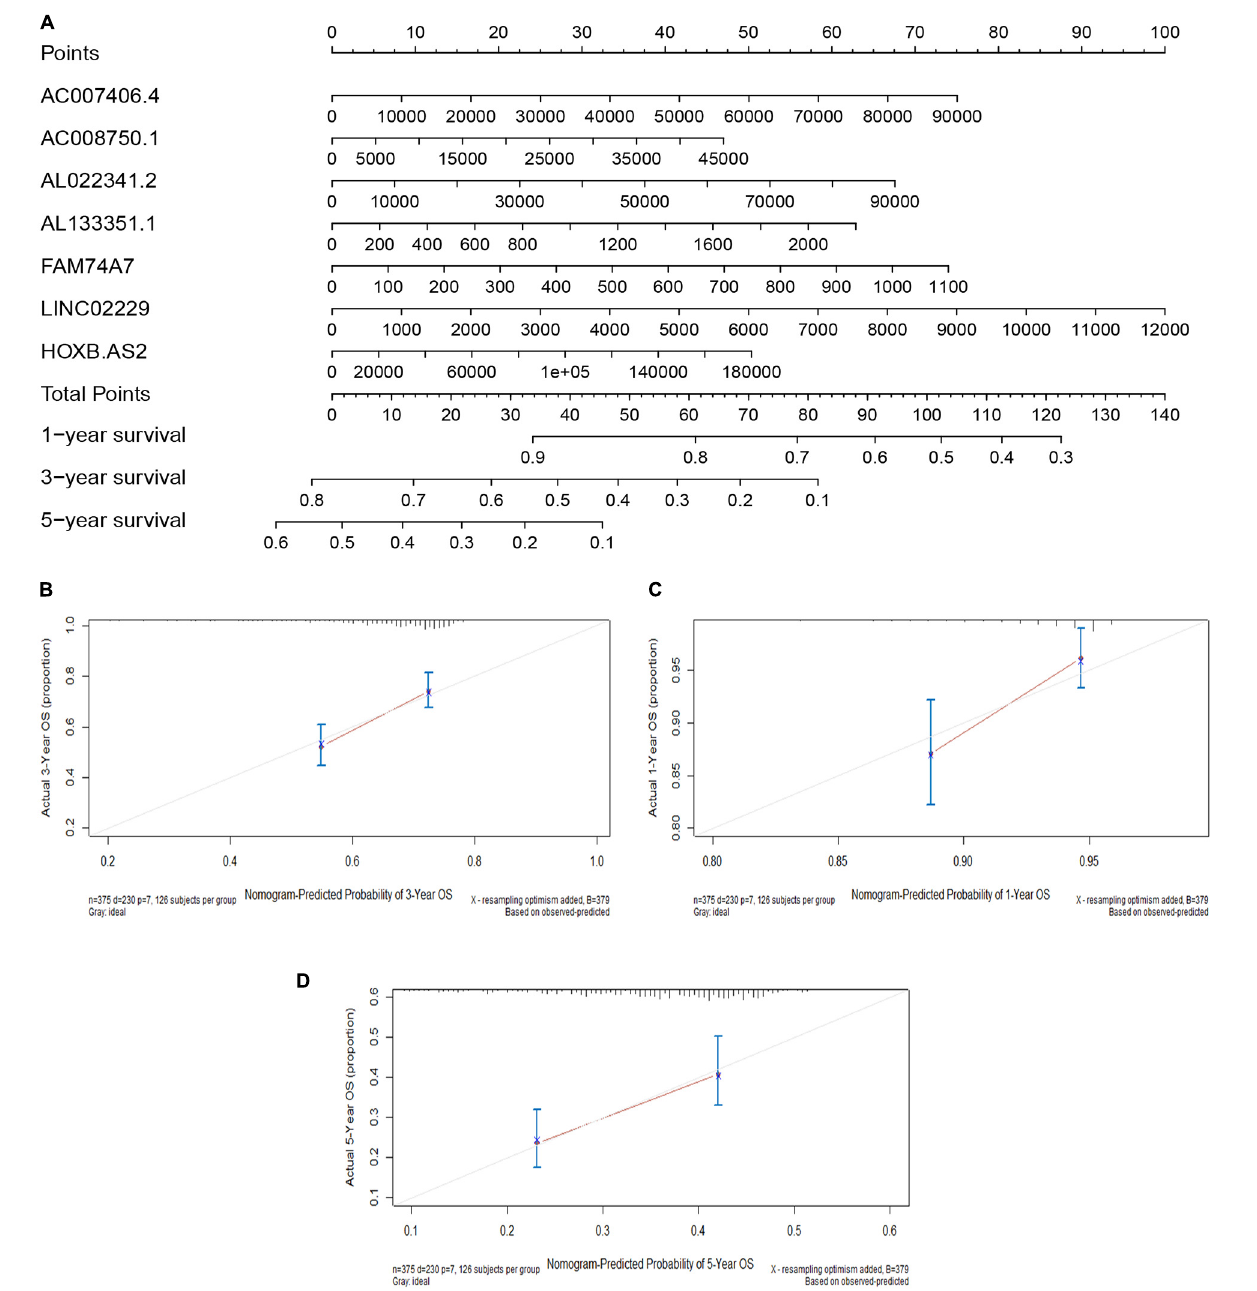
FIGURE 7 | Construction of a nomogram model. (A) A nomogram for predicting the 1-, 3-, and 5-year overall survival rates of OC patients. (B) The calibration curve at 1 year. (C) The calibration curve at 3 years. (D) The calibration curve at 5